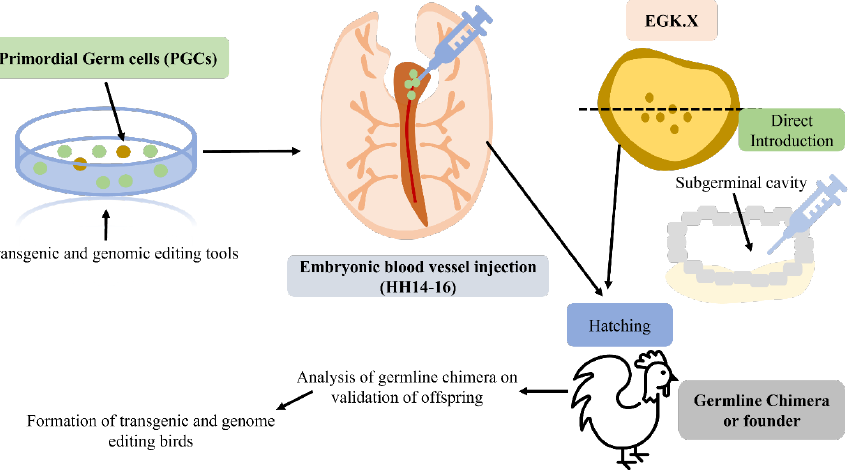
Figure 1. The intrusion of genetically modified PGCs via injection, entering the blood vessels of birds to produce transgenic (TG) and genome-edited (GE) offspring (modified from Han and Park [9]).